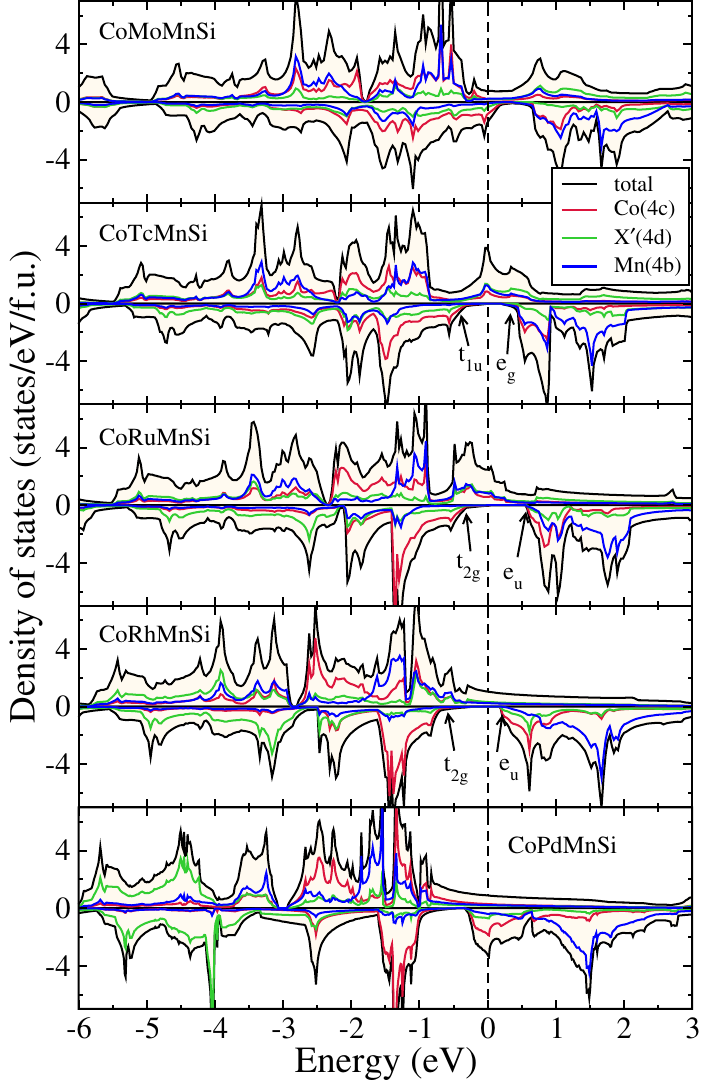
Figure 5. Spin polarized total and atom-projected densities of states for CoX ′ MnSi (X ′ = Mo, Tc, Ru, Rh, Pd) alloys. The ground states of these compounds are